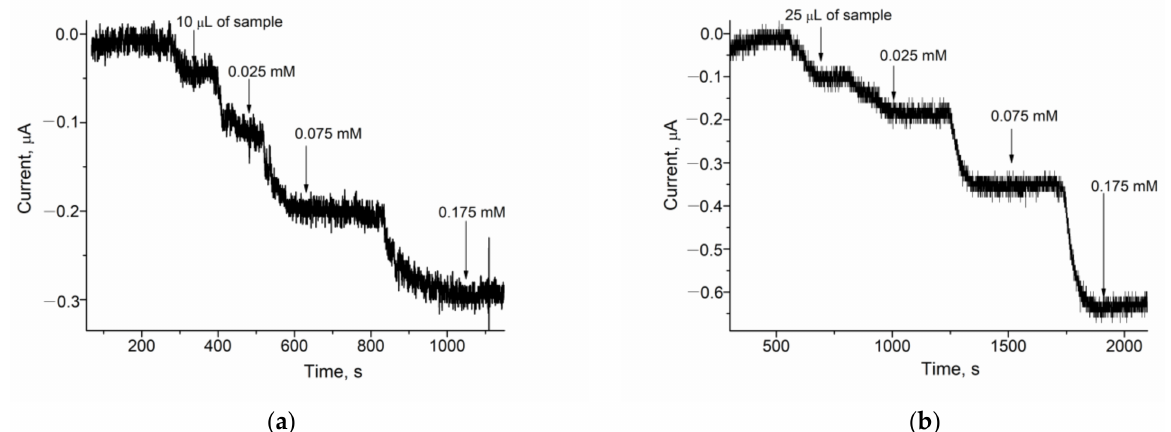
Figure A6. Determination of catechol content in the tested samples using the laccase/CuCo-based ABS. Chronoamperograms of the current responses upon catechol addition to the samples with dilutions: 33-fold ( a ) and 45-fold ( b ). The tested sample was wastewater supplemented with 1 mM catechol. Conditions: working potential +230 mV vs. Ag/AgCl, NaOAc buffer, 23 ◦